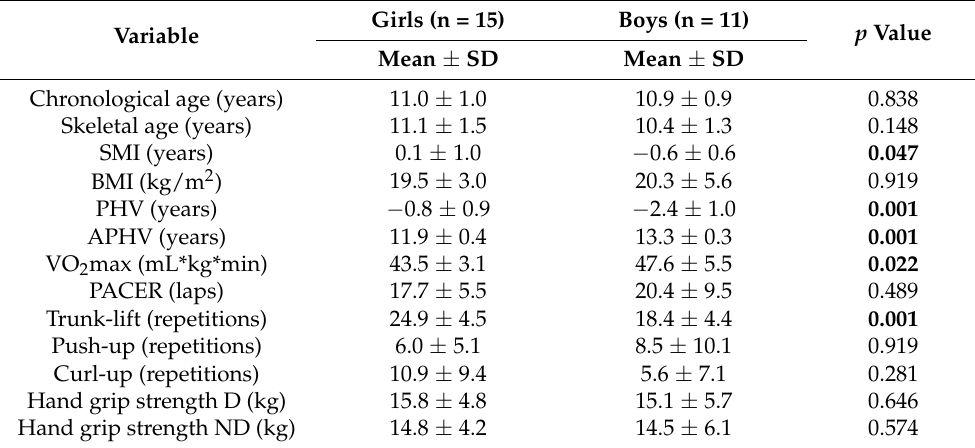
Table 1. The fitness and maturation variables by sex before the exercise program.